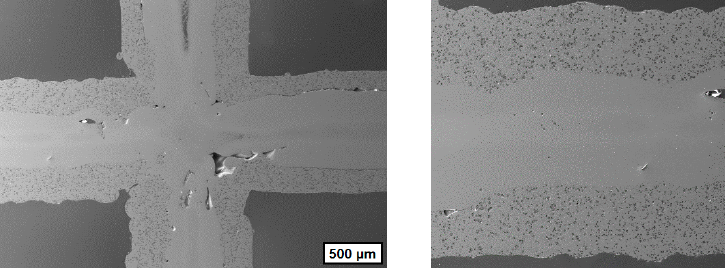
Materials 2019 , 12 , x FOR PEER REVIEW